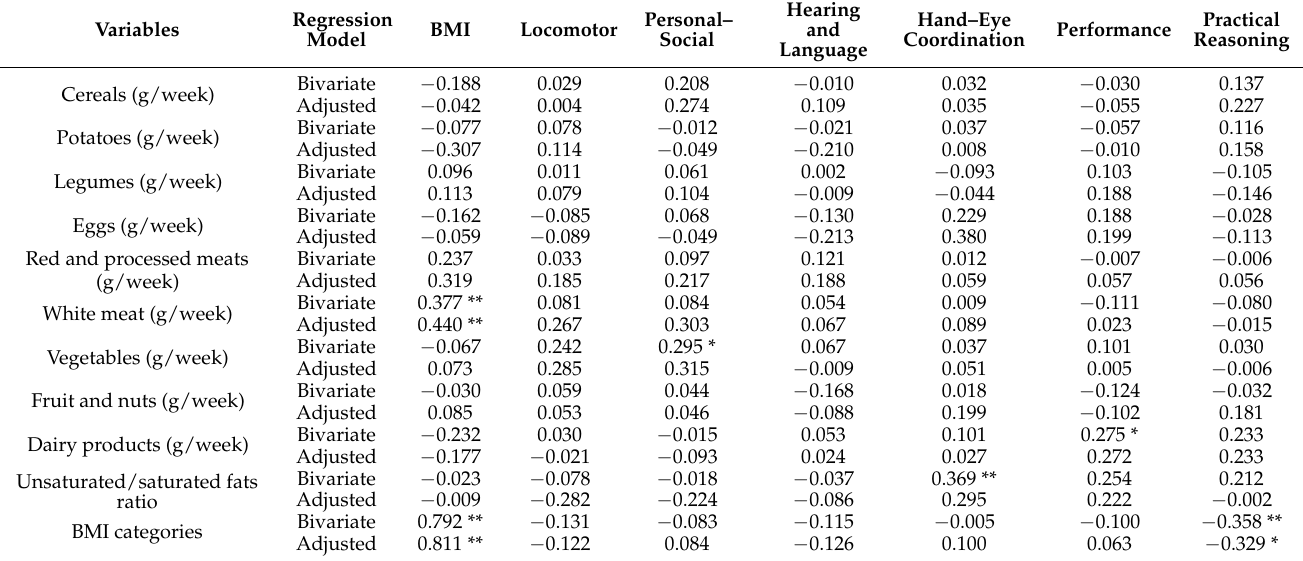
Table 3. Correlations between MD food categories and BMI (including BMI categories) and cognitive